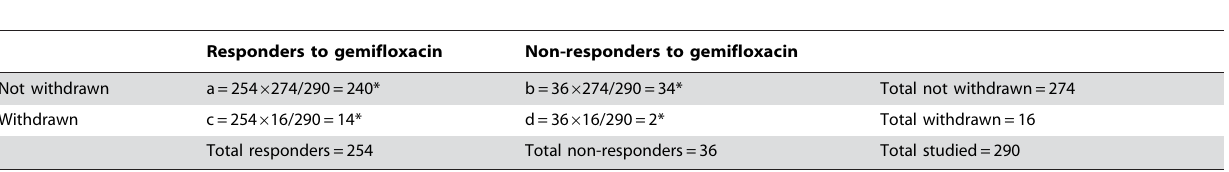
Table 4. Calculation of expected frequencies combining efficacy and safety with data belonging to a CRT in which gemifloxacin was assayed [6]. *=by rounding.